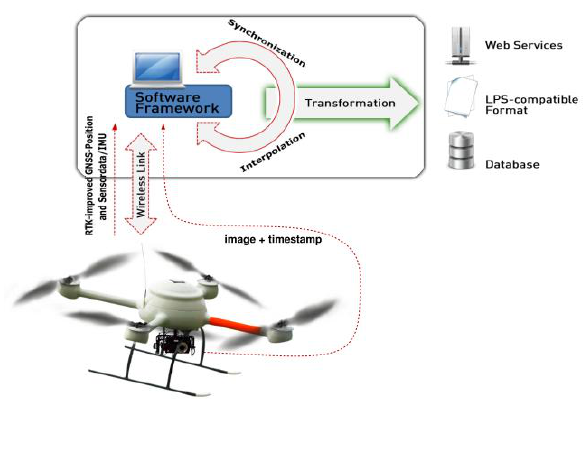
Figure 5: High-level communication